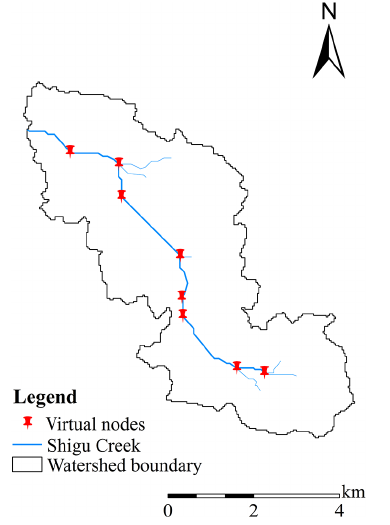
Figure 4. Liuxihe model structure in Shigu creek.